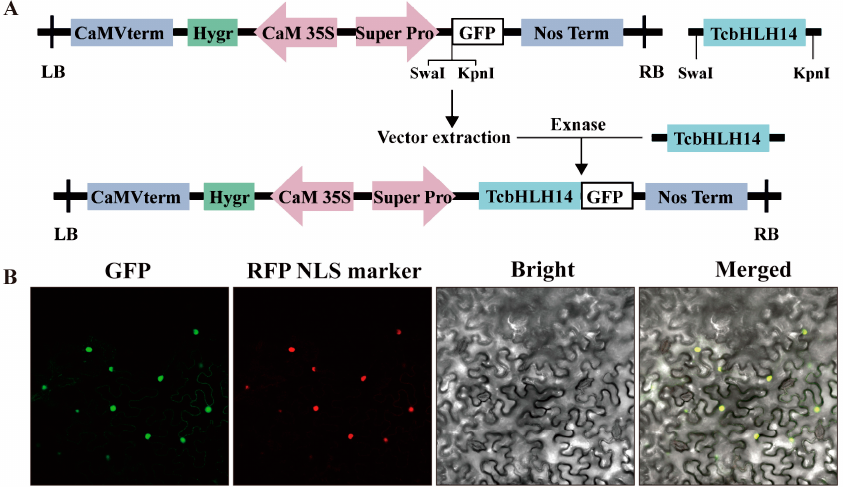
Figure 3. Subcellular localization of TcbHLH14. ( A ) Schematic diagram of vector construction. TcbHLH14 was inserted into the pSuper1300-GFP vector driven by the Super promoter. ( B ) Green fl uorescence emi tt ed by the TcbHLH14::green fl uorescent protein (GFP) fusion protein driven by the Super promoter. RFP NLS: the nuclear-labeled fusion protein emits red fl uorescence; Bright: ordinary light source; Merged: fusion of green and red fl uorescence and ordinary light.